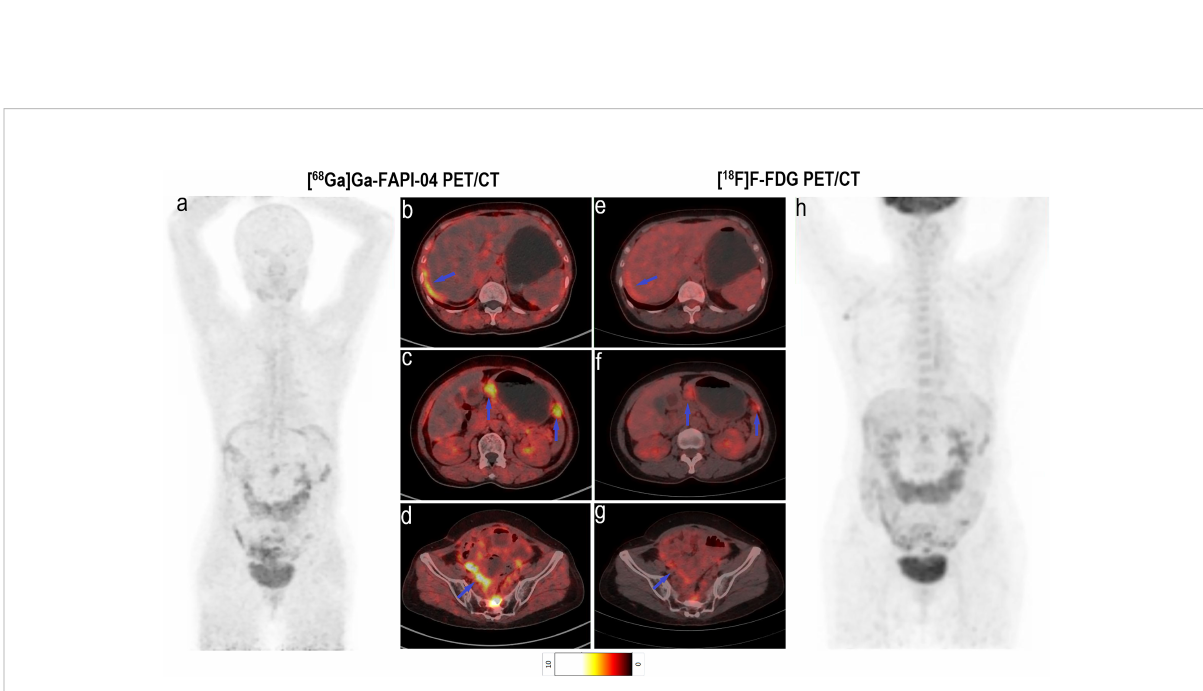
FIGURE 5 Images of a 60-year-old woman with colon cancer and metastatic peritoneal carcinoma for restaging after treatment. (A) Mean intensity projection images of [ 68 Ga]Ga-FAPI-04 PET/CT scans. (B – D) Axial fused images of metastatic peritoneal carcinomas at different body levels in [ 68 Ga]Ga-FAPI-04 PET/CT. (E – G) Axial fused images of metastatic peritoneal carcinomas at different body levels in [ 18 F]F-FDG PET/CT. (H-h) Mean intensity projection images of [ 18 F]F-FDG PET/CT scan. [ 68 Ga]Ga-FAPI-04 uptake (blue arrows in B – D ) was higher than the [ 18 F]F-FDG uptake (blue arrows in E – G ) in peritoneal carcinomas, and SUV max values for [ 68 Ga]Ga-FAPI-04 and [ 18 F]F-FDG PET/CT were 4.6 – 8.8 and 3.1 – 3.5,